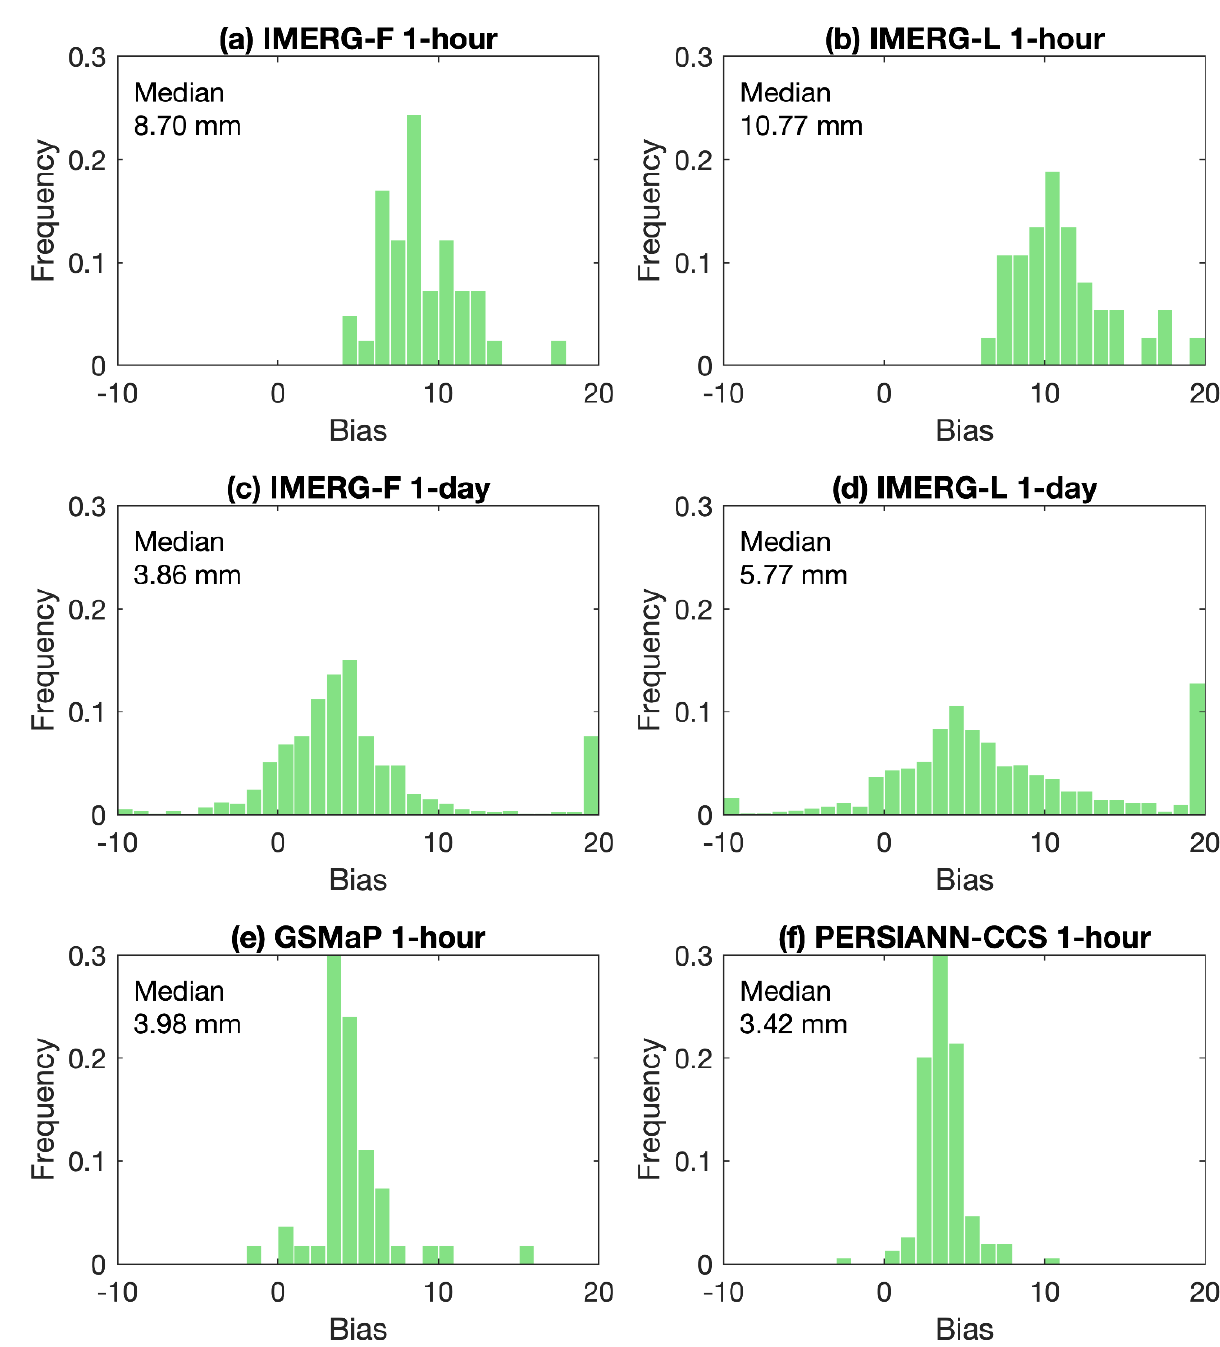
Figure 11. The Bias of hourly and daily extreme precipitation from 2000 to 2018. In terms of the mean error, the median hourly BIAS of IMERG-F, IMERG-L, GSMaP, and PERSIANN-CCS are 8.7, 10.77, 3.98, and 3.42 mm. Notably, both IMERG-F and IMERG-L overestimate precipitation. Among them, the relative error of IMERG-F is small: better than IMERG-L and slightly worse than GSMAP and PERSIANN-CCS. However, GSMaP and PERSIANN-CCS have a certain underestimation of precipitation. The median daily BIAS of IMERG-F and IMERG-L were 3.86 and 5.77. Similarly, IMERG-F was better than